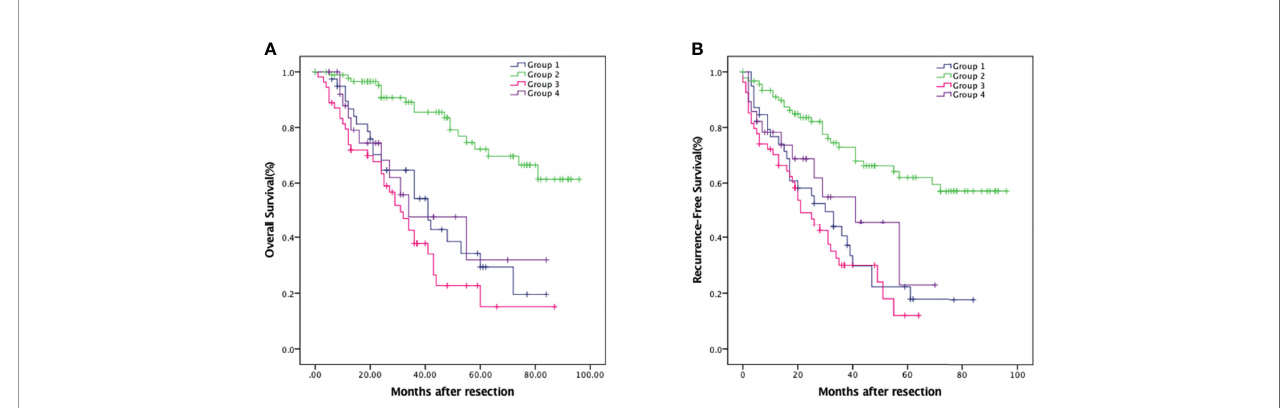
FIGURE 4 | Kaplan – Meier survival analysis of HCC patients showing survival curves strati fi ed according to the combination of NLR and PNI. OS (A) and RFS (B) curve comparing different groups. Group 1, NLR <3.29 and PNI <43.75 (n = 42); Group 2, NLR <3.29 and PNI ≥ 43.75 (n = 91); Group 3, NLR ≥ 3.29 and PNI <43.75 (n = 54); Group 4, NLR ≥ 3.29 and PNI ≥ 43.75 (n =